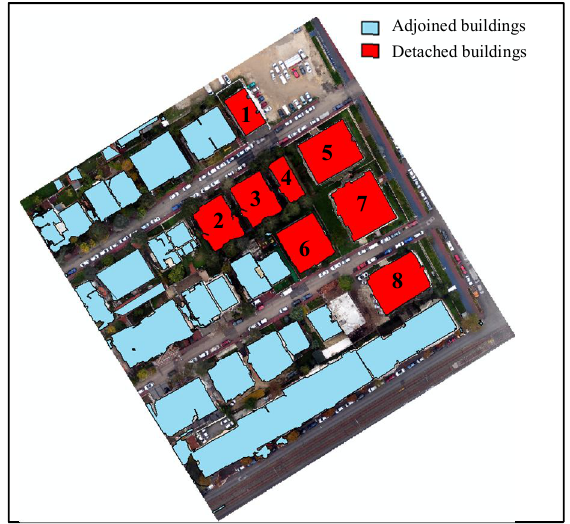
Figure 5. Extracted buildings with